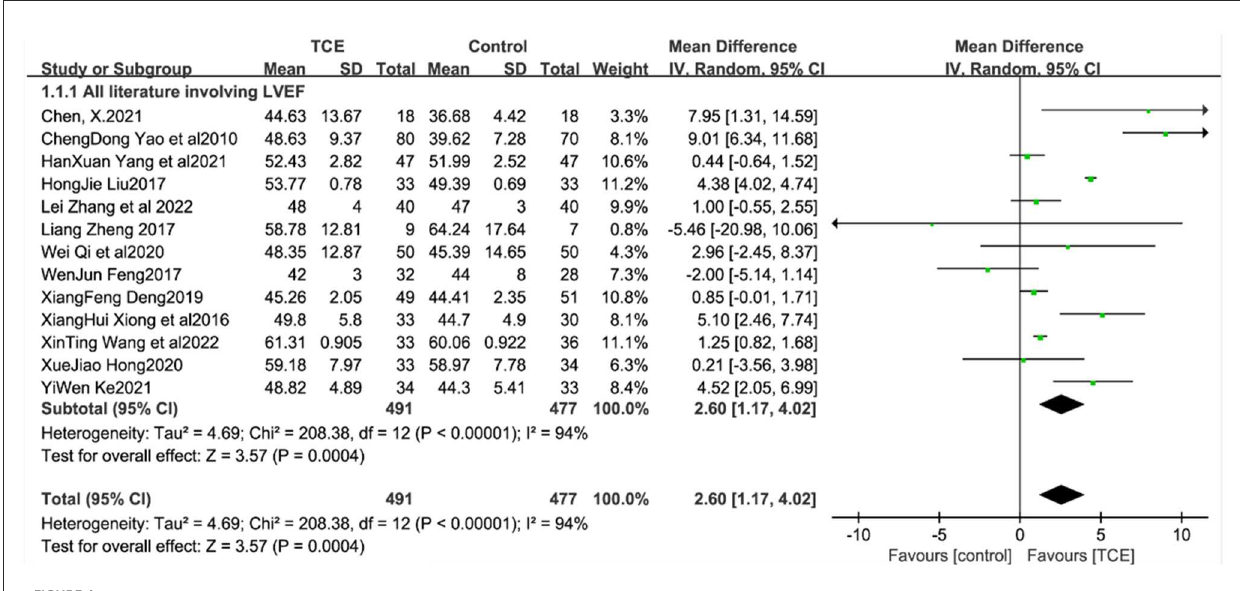
FIGURE4 The effect of Traditional Chinese exercises on patients’